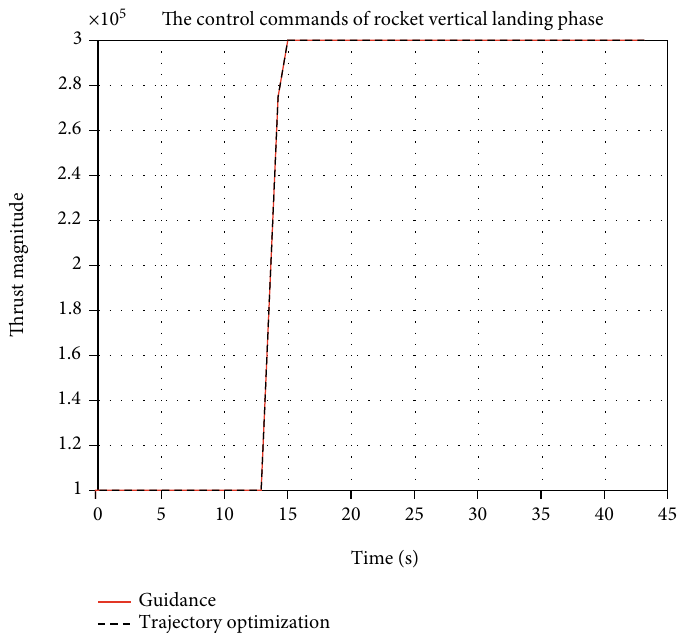
Figure 5: The control commands of rocket vertical landing phase obtained by the guidance method and the trajectory optimization